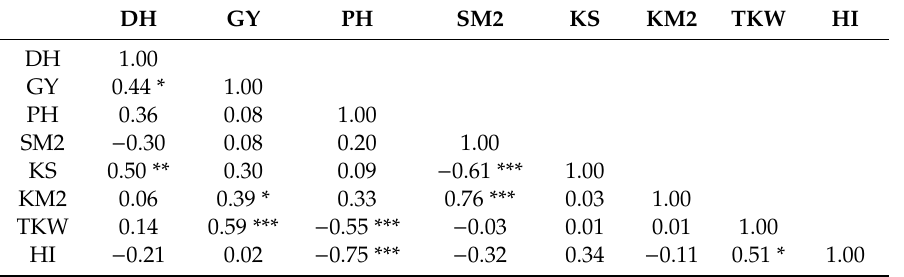
Table 3. Correlation matrix among agronomic traits evaluated in ten cultivars during three growing seasons